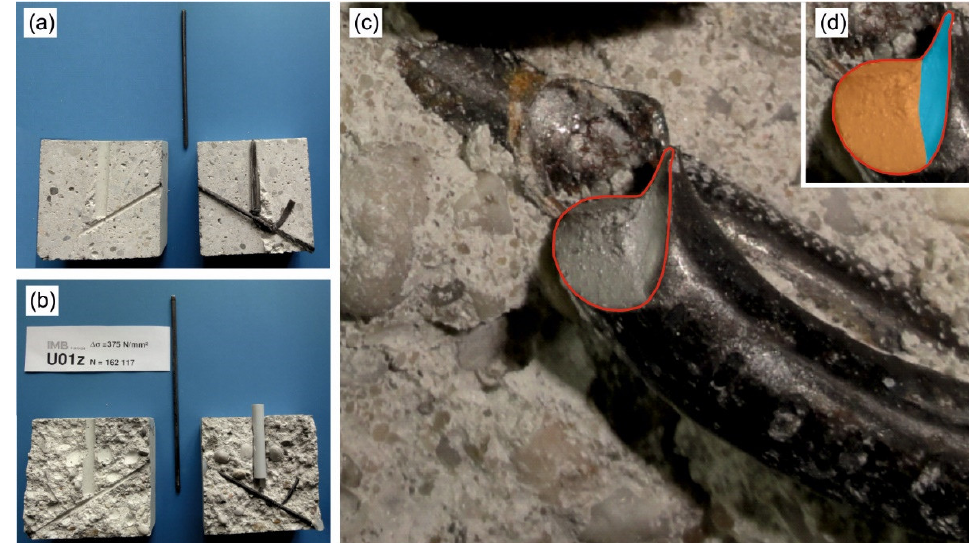
Figure 7. Fracture pattern of small size specimen under monotonic loading ( a ), cyclic loading ( b ), and fatigue fracture of welded node (red marking) ( c ) with definition of fatigue zone (orange) and final rupture zone (blue) ( d ).